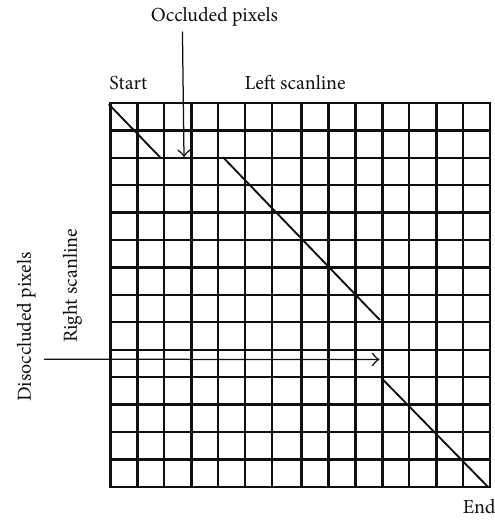
Figure 1: Dynamic programming for stereo